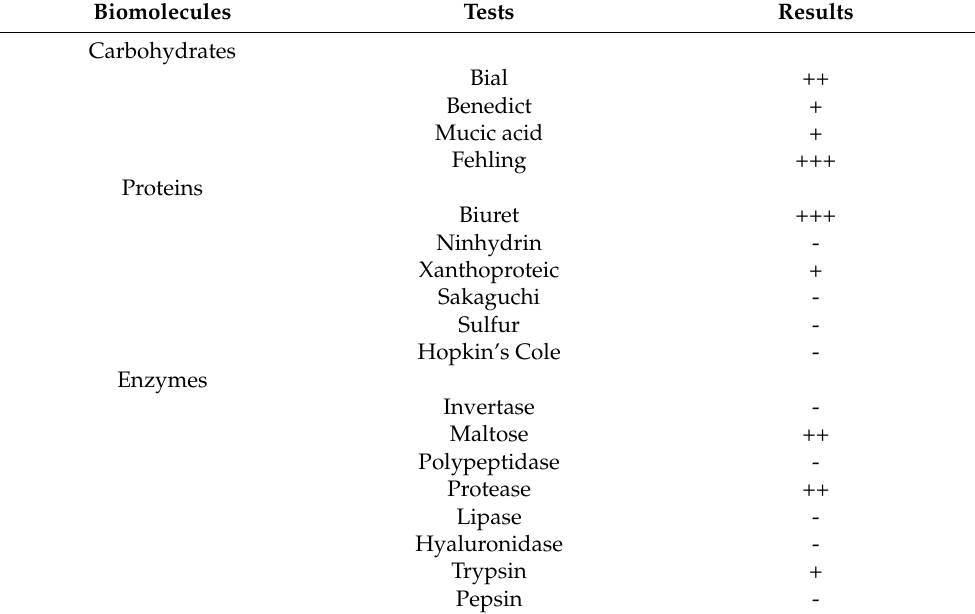
Table 4. Qualitative chemical screening of the foam produced by P. costalis